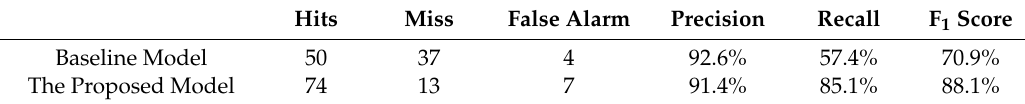
Figure 6. Comparison of detected and annotated number of traffic events. Table 6. Performance comparison of Baseline and the proposed